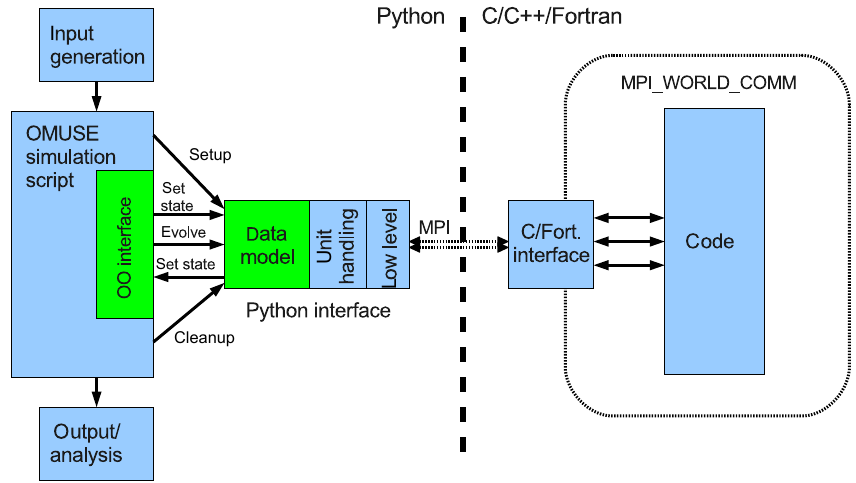
Figure 1. Design of the OMUSE framework. This schematic representation shows the design of the interface to a community code (“code”) and the way it is accessed from the OMUSE framework. The code has a thin layer of interface functions in its native language (e.g., Fortran), which communicates through an MPI message channel with the Python host process. On the Python side, the user script (“OMUSE simulation script”) makes only generic calls to a high-level interface. This high-level interface calls the low-level interface functions, hiding details about units and the code implementation (the communication through the MPI channel does not interfere with the code’s own parallelization because the latter has its own MPI_WORLD_COMM context). Adapted from Pelupessy et al. (2013).